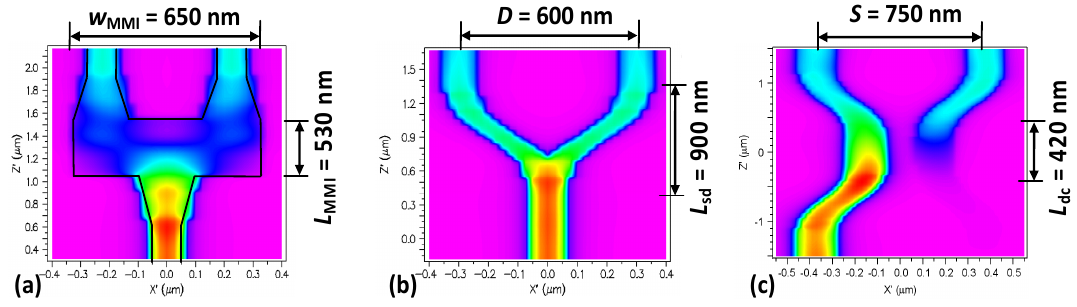
Figure 4. The designed 3 dB power splitters based on ( a ) a 1 × 2 MMI coupler with the length L MMI = 530 nm and the width W MMI = 650 nm; ( b ) a Y-branch with the length L S-bend = 900 nm and the separation D = 600 nm; and ( c ) a direction coupler with the length L dc = 420 nm and the separation D = 750 nm. The waveguide width w co = 150 nm, the thickness of the SiO 2 slot layer, h SiO2 = 20 nm [79].